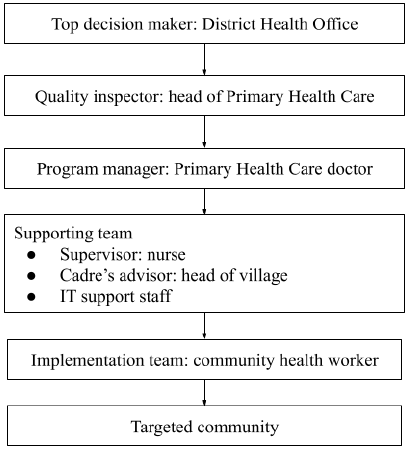
Figure 5. Organizational framework of PHC